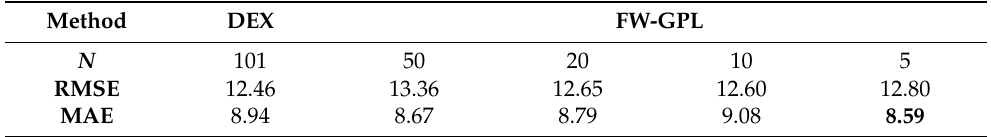
Table 11. Test performance between the DEX and the FW-GPL with fragmentary IMDB-WIKI dataset. (length of the window set as